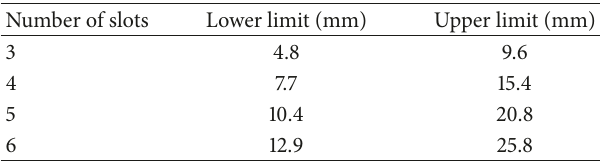
Table 1: Design constraints for the off-center